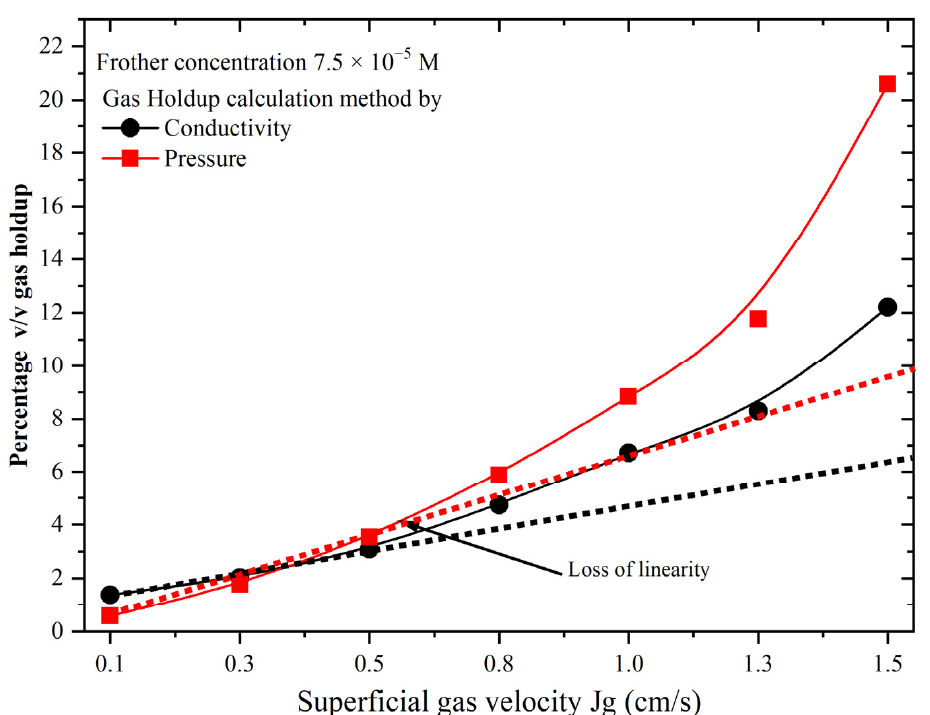
Figure 5. Percentage of v / v gas holdup as function of superficial gas velocity Jg (cm/s), Jl 0.19 cm/s, [e] 7.5 × 10 − 5 M, rigid sparger. Percentage of v / v Eg Differentiation by pressure and conductivity. The red and black dotted lines indicate the loss of linearity.